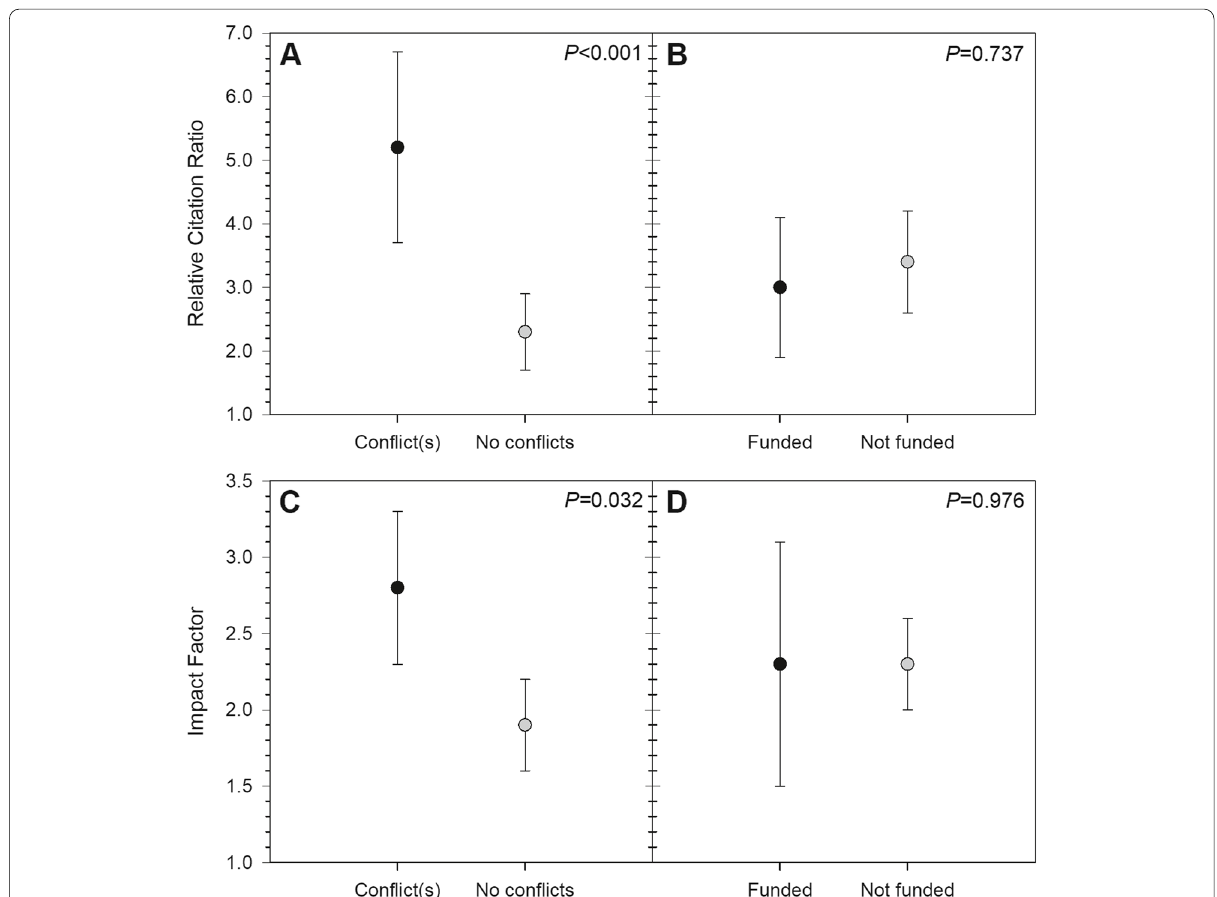
Fig. 4 Means (circles) and their 95% confidence intervals (error bars) for Relative Citation Ratio (RCR) and Impact Factor (IF). Studies were compared for any reported conflicts of interest vs . no reported conflicts of interest ( A : RCR; C : IF), and any reported industry funding vs . no reported industry funding ( B : RCR; D : IF). Studies reporting conflicts of interest tended to have significantly higher RCR and IF than those reporting no conflicts. Funded and unfunded studies did not differ significantly for RCR or